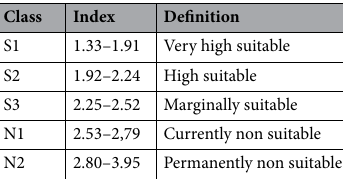
Table 3. Land suitability classes and their index values for agriculture